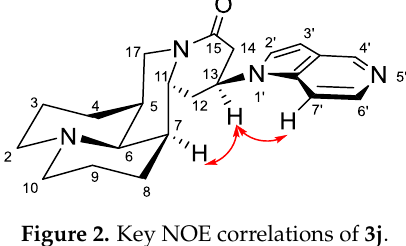
Figure 2. Key NOE correlations of 3j .